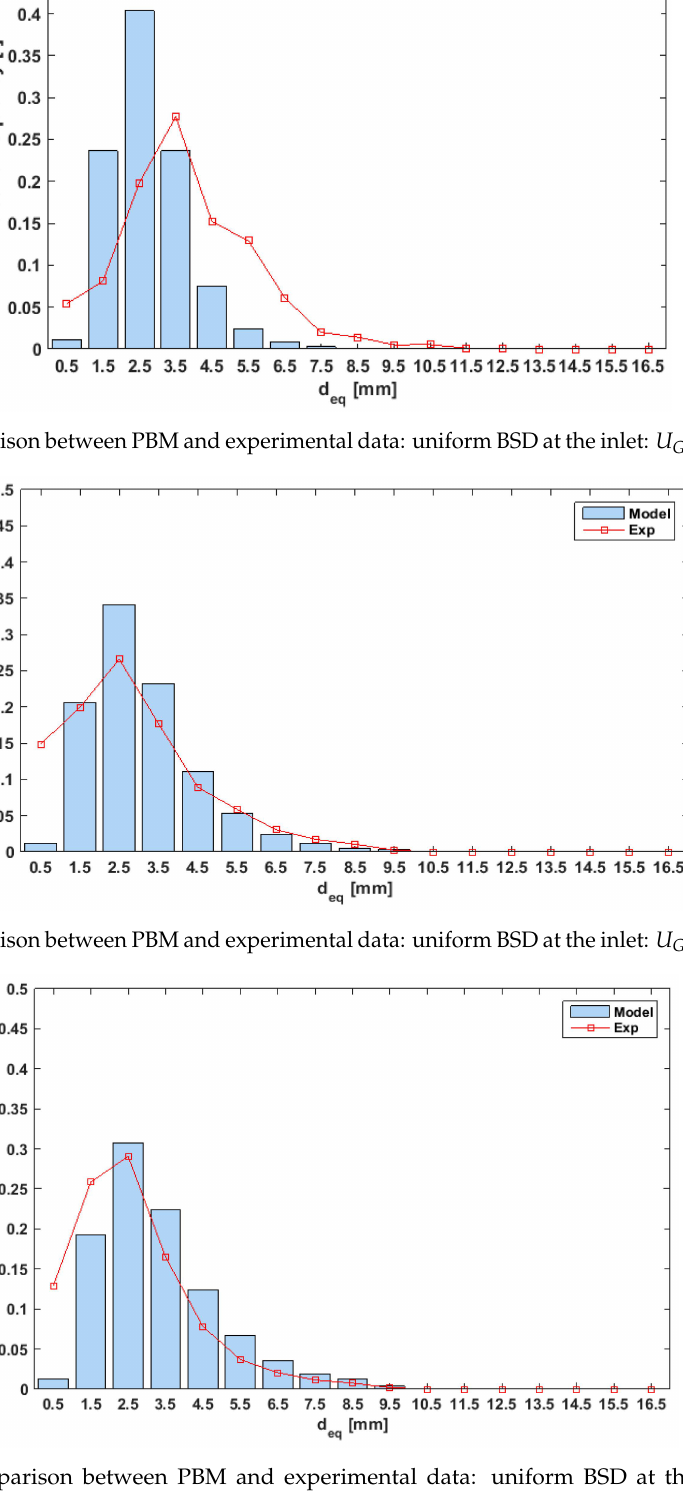
Figure 10. Comparison between PBM and experimental data: uniform BSD at the inlet: U G = 0.0149